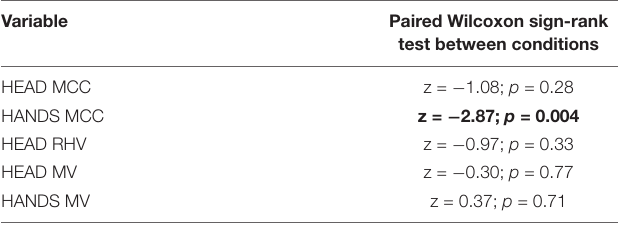
TABLE 1 | Paired Wilcoxon sign-rank tests between BASELINE and NO-HAND conditions for the different kinematics variables.